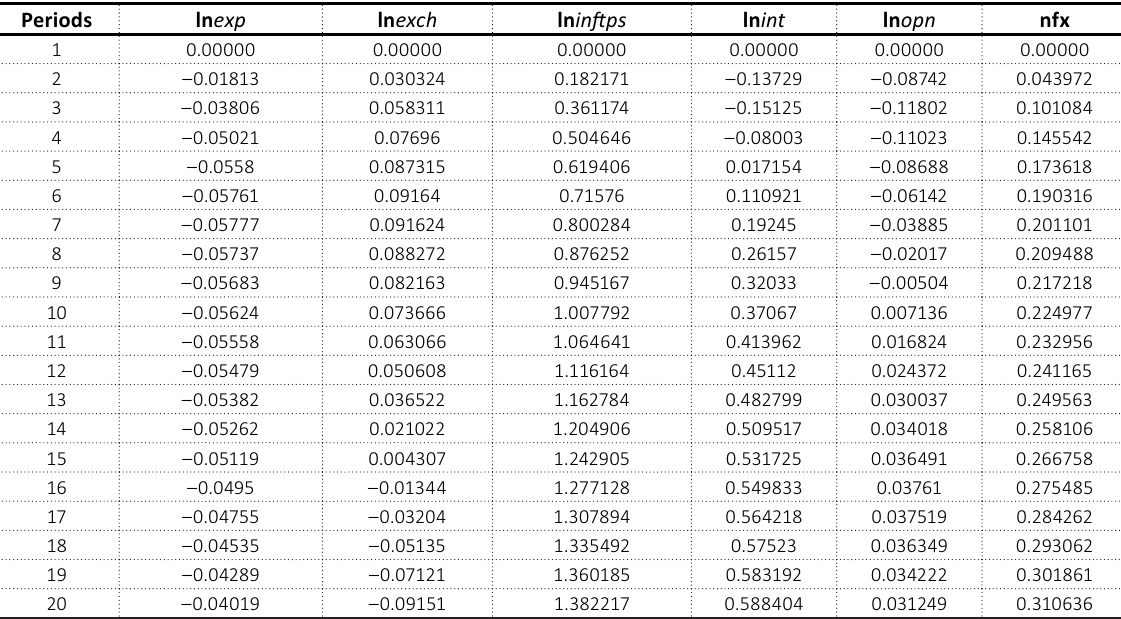
Table 6. Response of ln inf to Cholesky 1 Standard Deviation Innovations